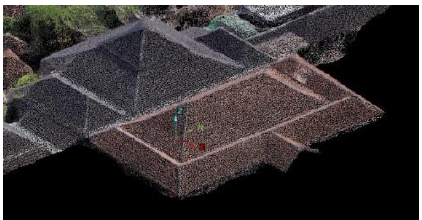
Figure 2. High density of UAV photogrammetric pointclouds at the roof part of